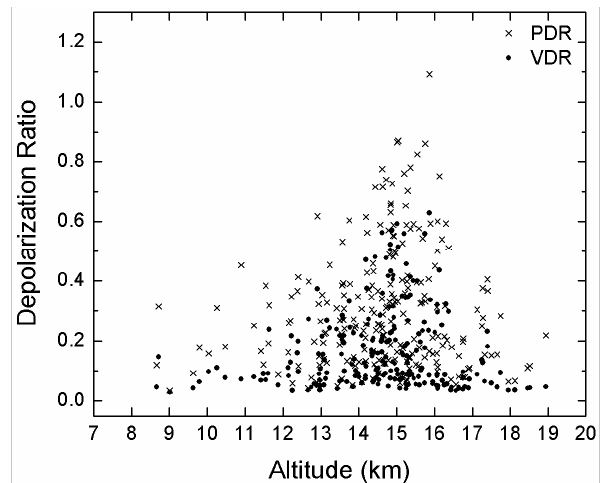
Figure 12 Fig. 12. Scatter plot showing the altitude dependence of volume de- polarization ratio (VDR) and particulate depolarization ratio (PDR) of tropical cirrus averaged for individual nights.